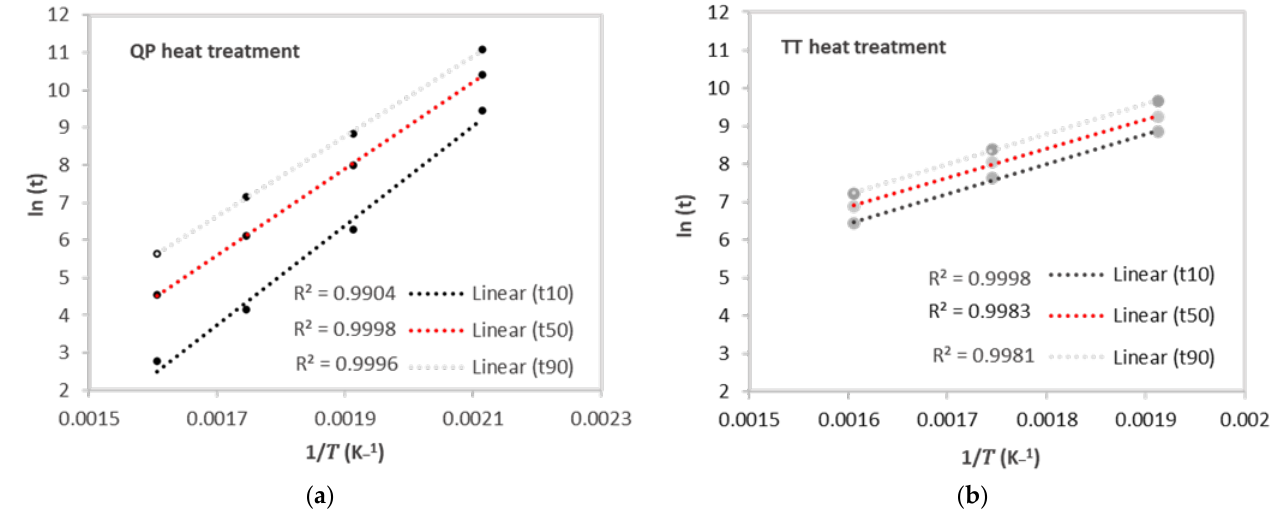
Figure 6. Arrhenius plot of ln(t i ) versus 1/T used to determine the activation energy: ( a ) QP; ( b ) TT.